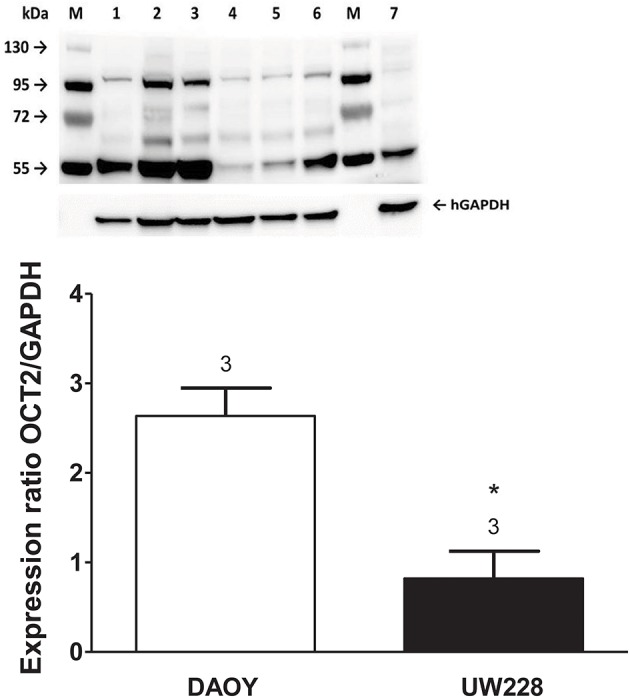
(Upper) Western blot analysis of hOCT2 expression in DAOY and UW228 cells. M is the marker lane. 1, 2, 3 are lysates from three different DAOY passages; 4, 5, and 6 are lysates from three different UW228 passages. Lane 7 contains lysate from hOCT2-HEK cells as a control. The respective bands corresponding to the signal of GAPDH are also shown. (Lower) Densitometric analysis of the Western blot, showing the hOCT2 expression in relation to the GAPDH expression. Above the columns is the number of experiments. The asterisk (*) indicates a statistically significant difference compared to the other column (unpaired t-test).